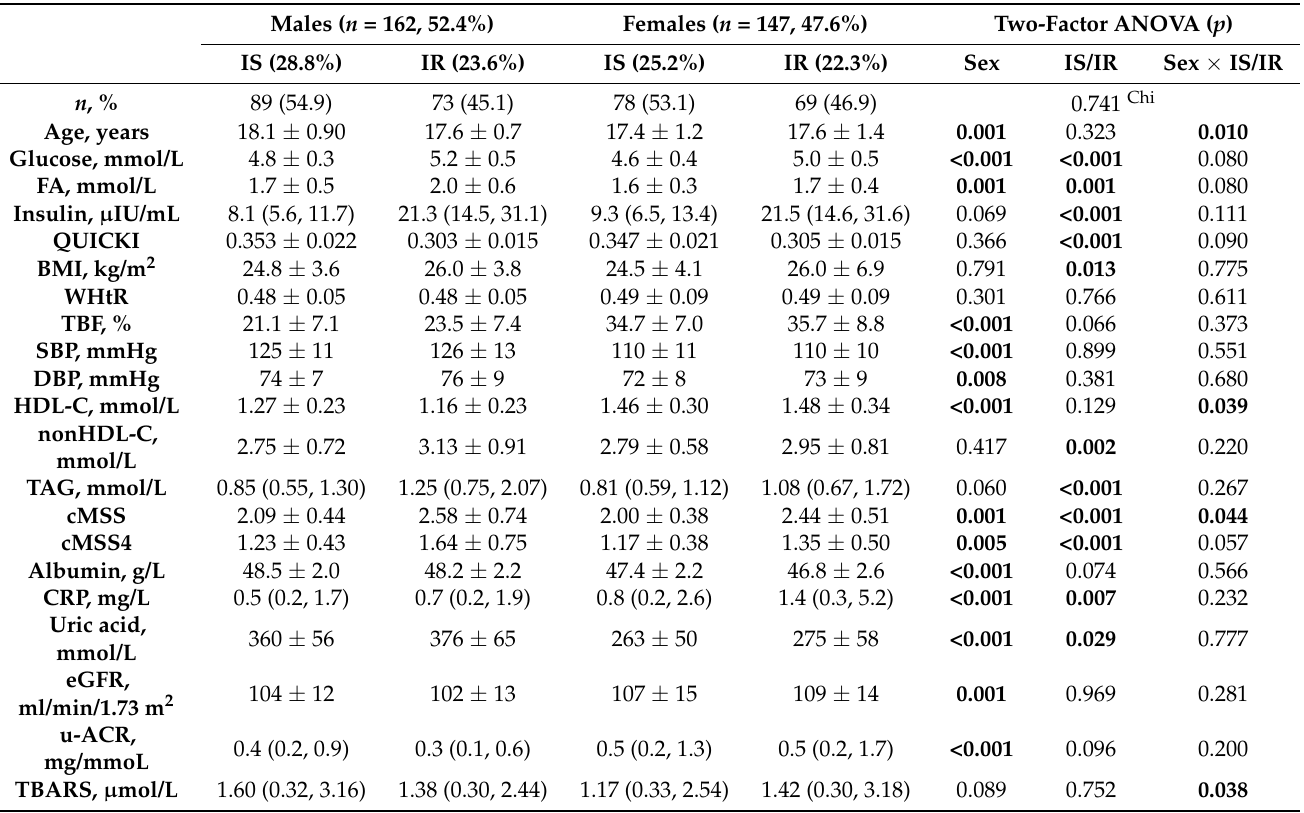
Table 1. Cohort characteristics.